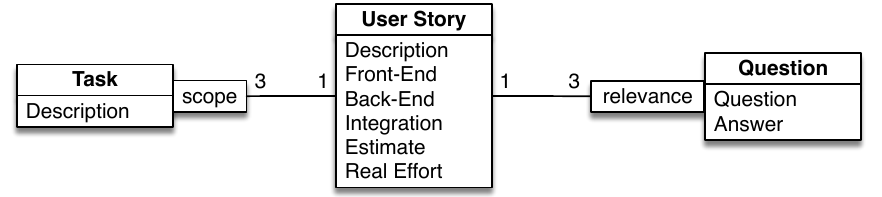
Figure 4. User Story and Question attributes and relationship.